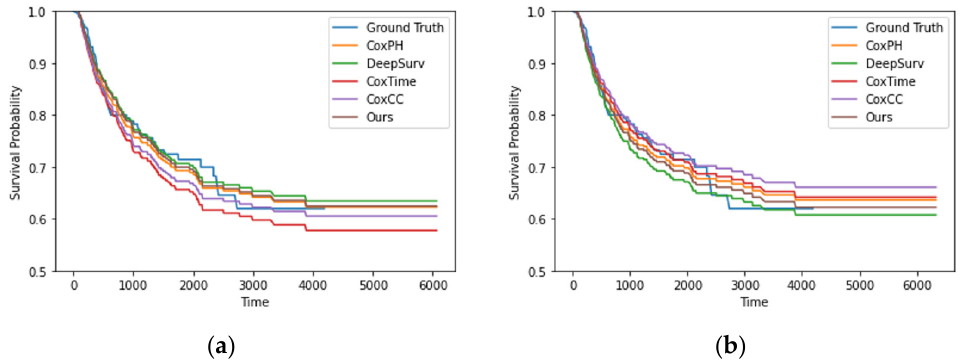
Figure 3. Survival curves for each model in the test set: ( a ) before treatment; ( b ) after treatment.